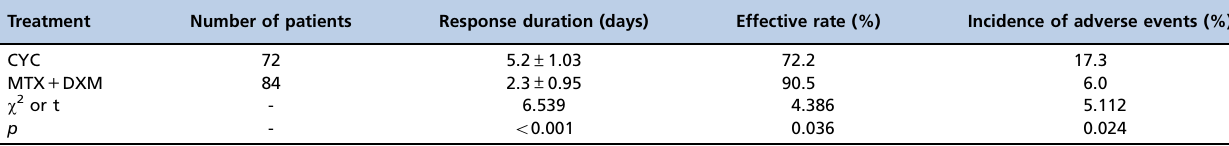
Table 4 - Comparison of the intravenous cyclophosphamide and intrathecal methotrexate plus dexamethasone.